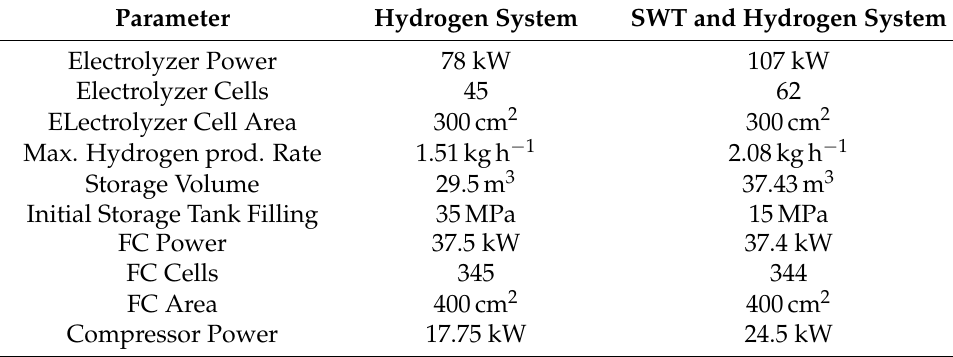
Table 15. System parameter overview.